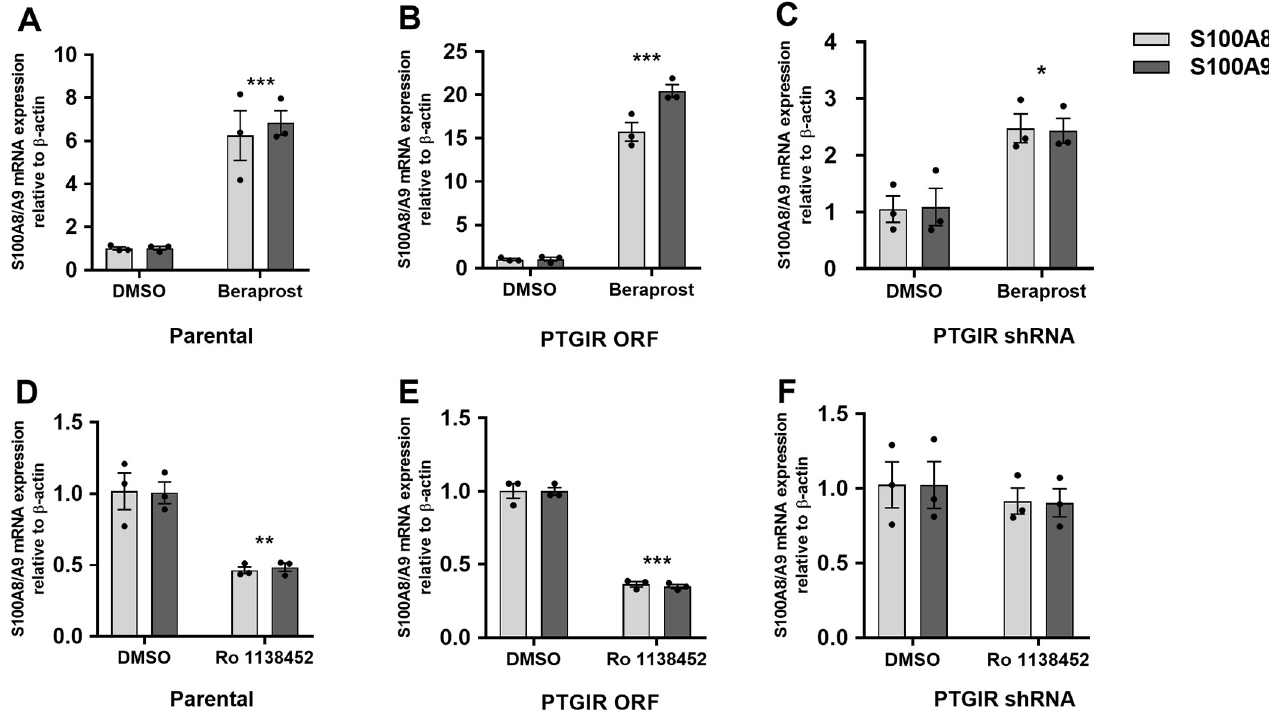
Fig 3. Impact of PTGIR agonist/antagonist on CP genes expression in THP-1: parental, PTGIR expressed or knocked-down. Relative mRNA expression levels of S100A8/A9 genes were evaluated following the treatment of THP-1 parental cell line (A) with 10 − 5 M PTGIR agonist (Beraprost) or (D) with 10 − 5 M PTGIR antagonist (Ro 1138452) for 24 h. Relative in mRNA expression levels of S100A8/A9 genes were evaluated in THP-1 cell lines transduced with (B, E) PTGIR ORF or ( C, F ) PTGIR shRNA following a treatment with either DMSO and either 10 − 5 M PTGIR agonist (Beraprost) or 10 − 5 M antagonist (Ro 1138452) for 24 h. Each bar is the mean of 3 samples from 3 different infections ± SEM. � P < .05, ��� P < .001 (Student’s t -test unpaired). A dose and time- course response of S100A8/A9 RNA expression to PTGIR agonist Beraprost were performed in parental THP-1 cells ( S12 and S13 Figs, respectively ); A dose response of S100A8/A9 RNA expression to PTGIR antagonist Ro 1138452 was performed in THP-1 cells transduced with the PTGIR ORF ( S14 Fig ).